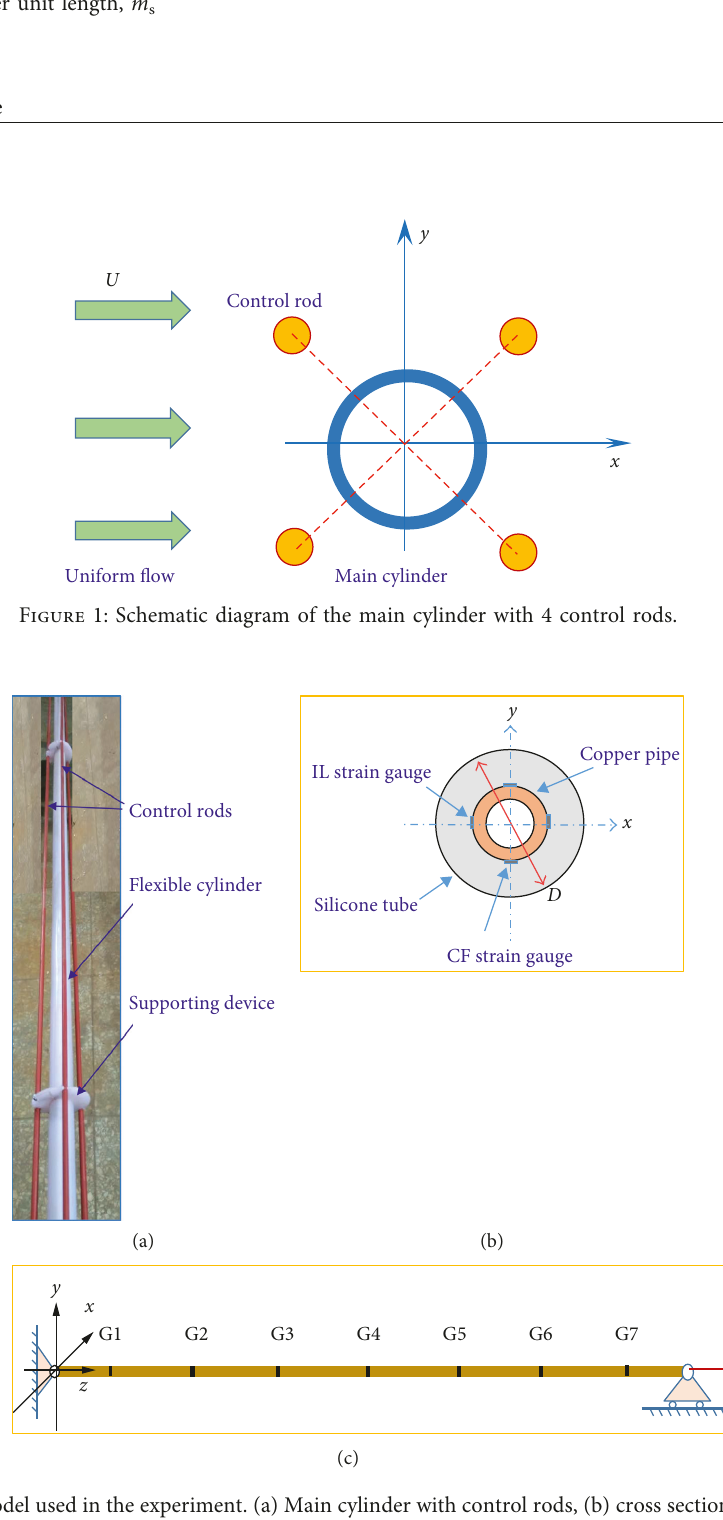
Figure 2: Flexible cylinder model used in the experiment. (a) Main cylinder with control rods, (b) cross section view of the main cylinder, and (c) strain gauges’ positions along the main